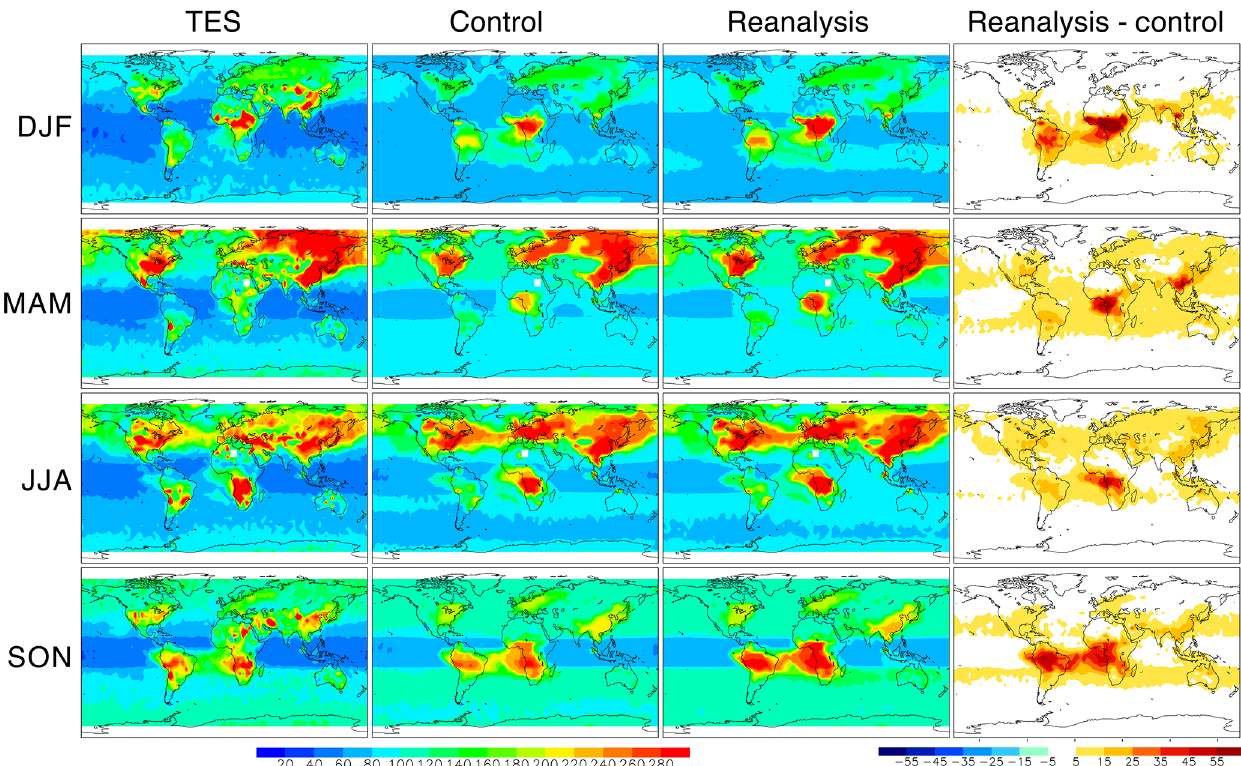
Figure 8. Global distributions of the PAN concentrations (in ppt) averaged between 800 and 400hPa during 2005–2009. The results are shown for the TES retrievals (left column), model simulation (second column), reanalysis (third column), and the reanalysis minus model (right column) for DJF (top row), MAM (second row), JJA (third row), and SON (bottom